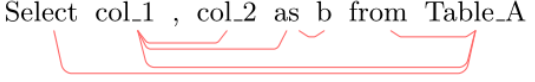
Figure 8. Minimum spanning tree exported by LaTeX.